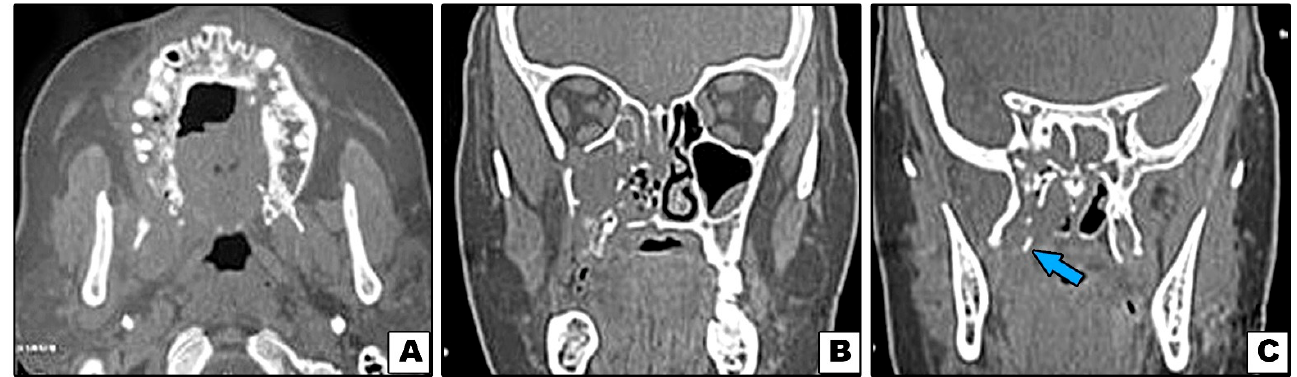
Figure 4. Case#7: ( A ) Exposed necrotic palatal and alveolar bone on left side. ( B ) 3D CT showing bone destruction involving left maxilla and lower part of zygoma.